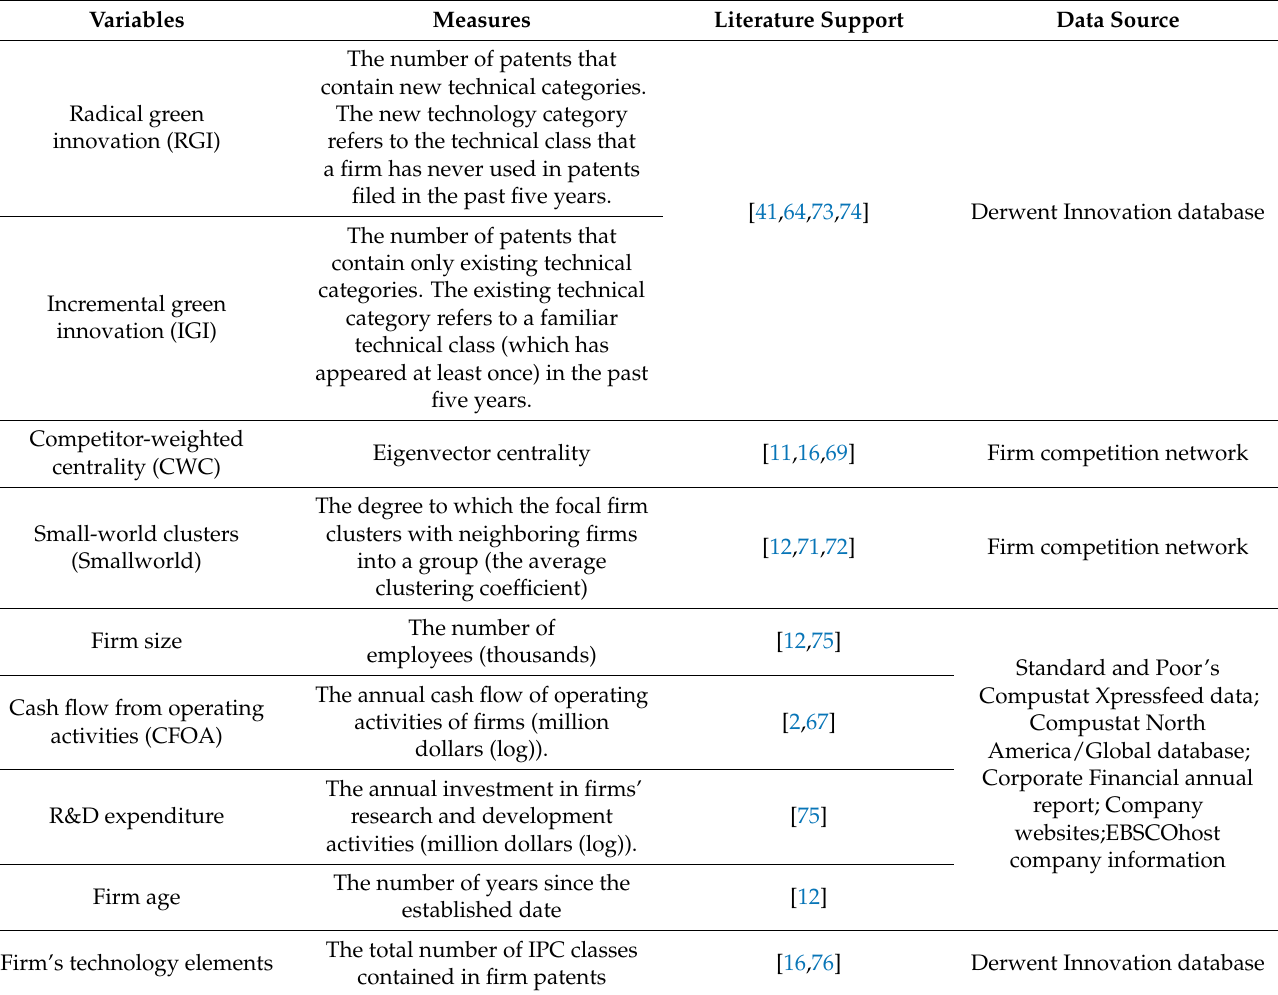
Table 1. Summary of